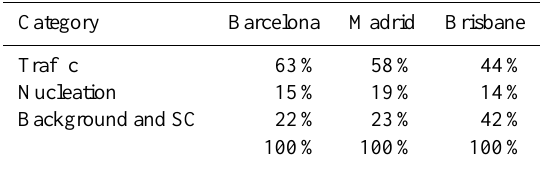
Table 3. Cluster categories (Traffic, Nucleation, Background and Specific cases, SC) and their occurrence at the main